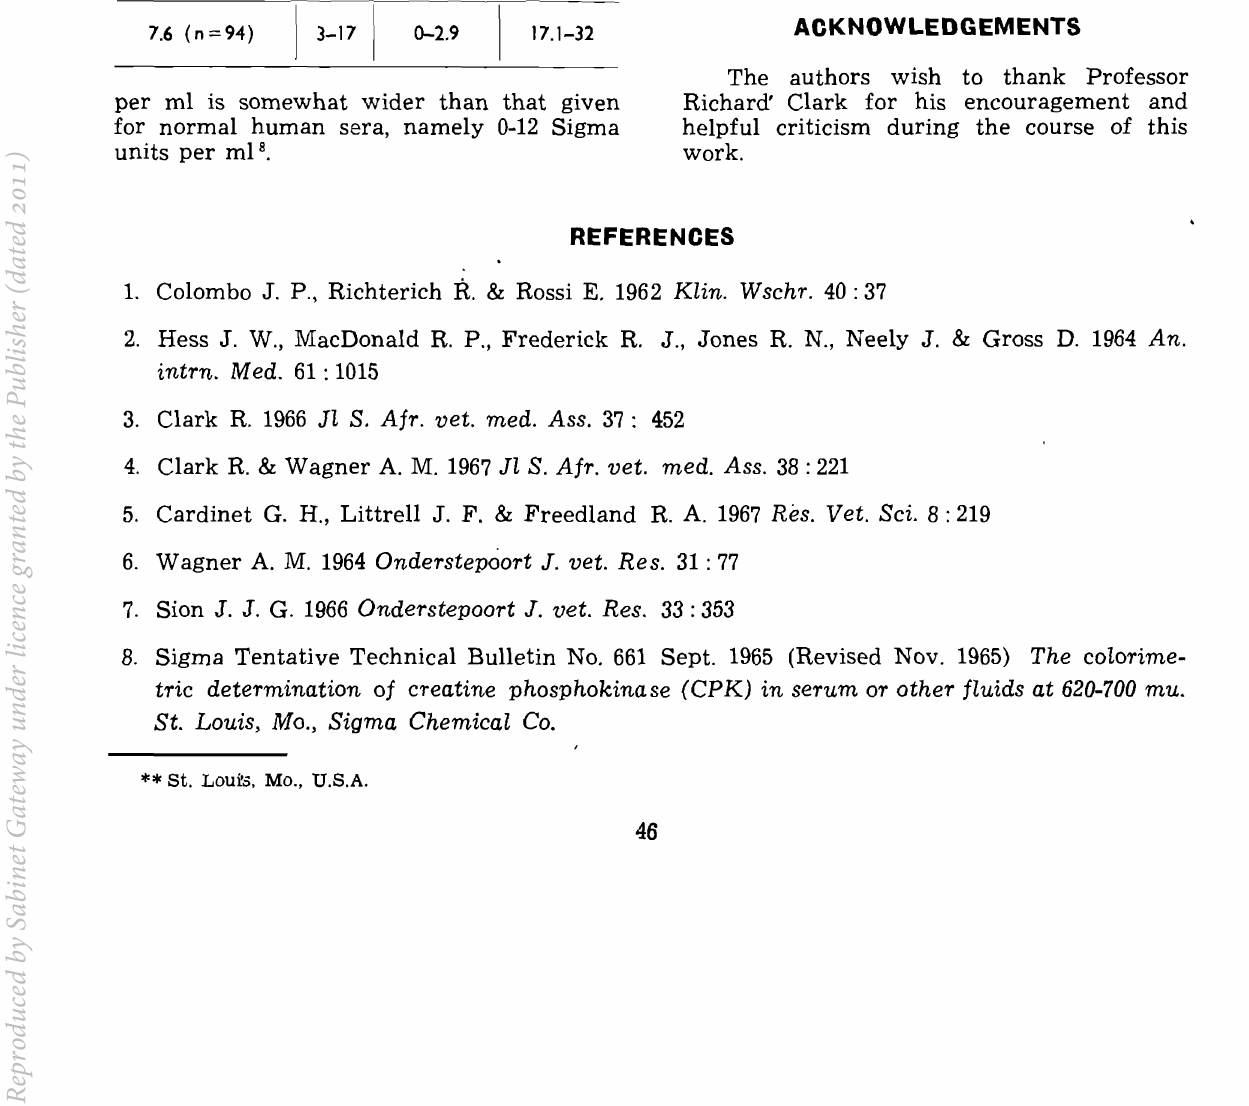
Table I-RANGES FOUND FOR CREATINE PHOSPHOKINASE (CPK) IN OVINE BLOOD